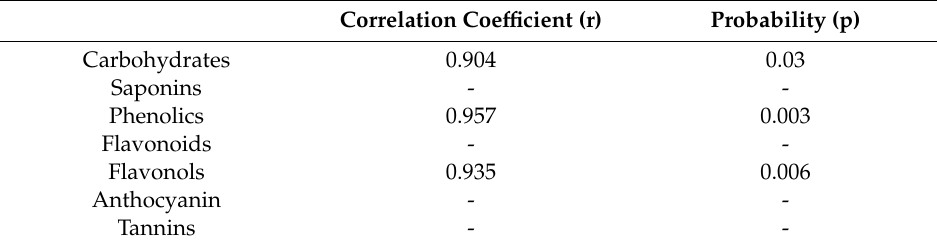
Figure 3. Total antioxidant capacity ( A ) and DPPH radical scavenging activity ( B – D ) of H. thebaica leaves, male parts and fruits. Table 2. Correlation between the detected metabolites and TAC of H. thebaica .